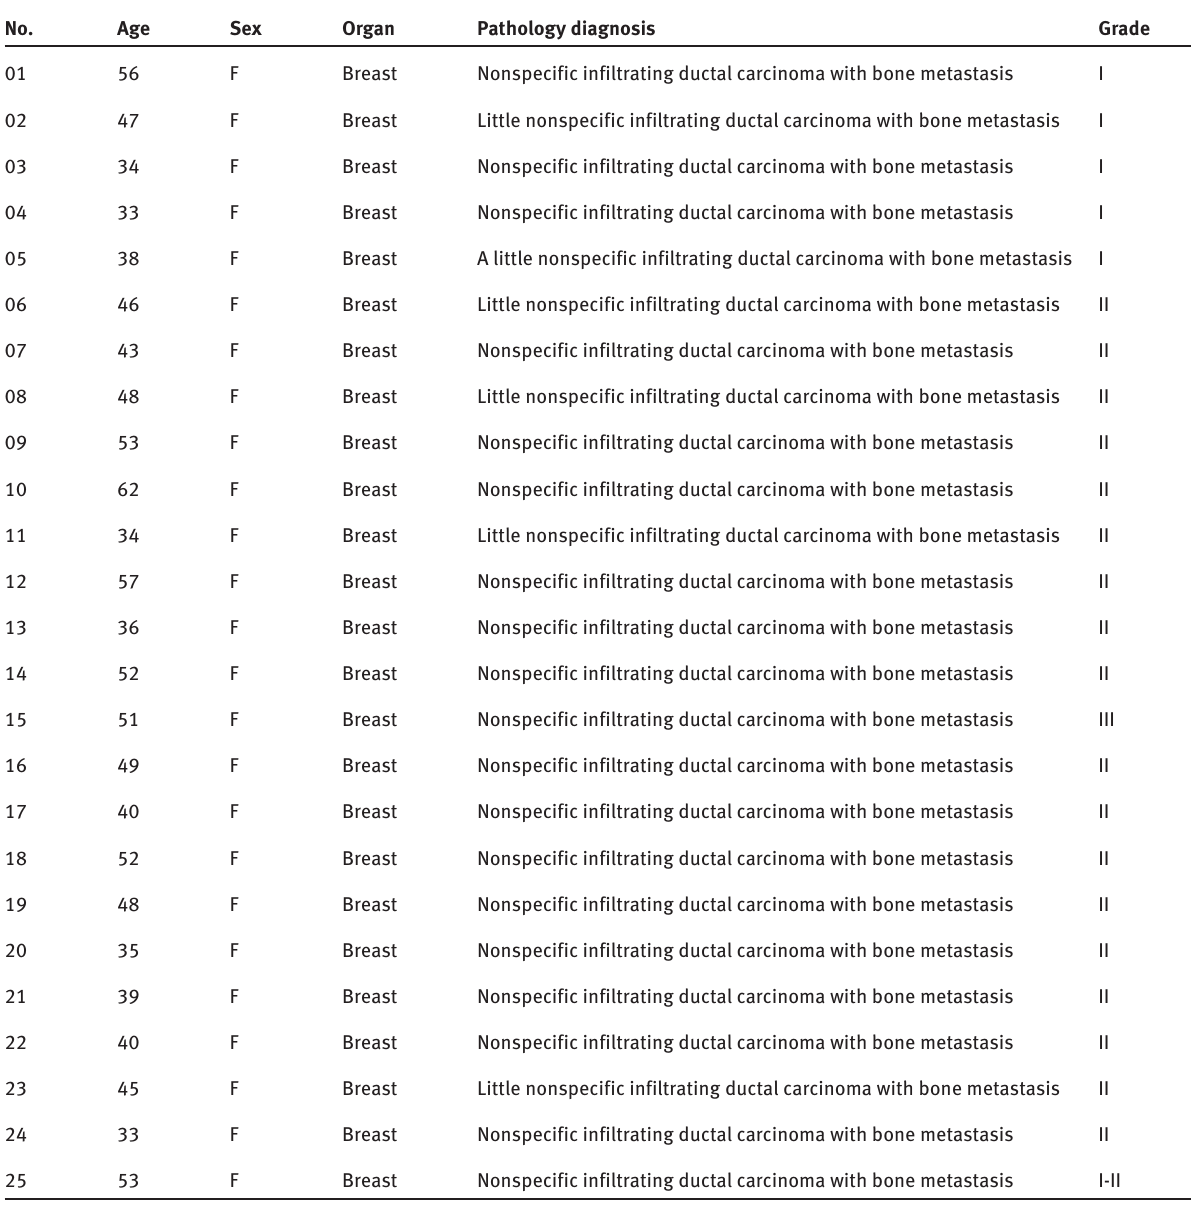
Table S1: Clinical characteristics of breast tumor samples